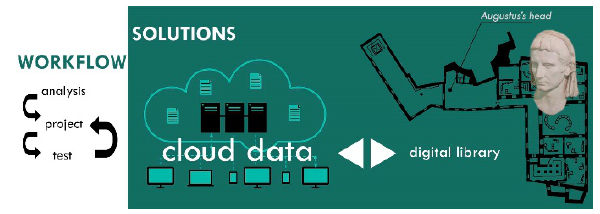
Figure 1. Structure and workflow of the project and its relative solutions and